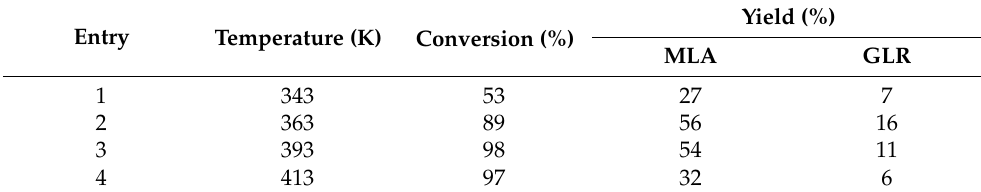
Table 2. Effect of reaction temperature on catalytic